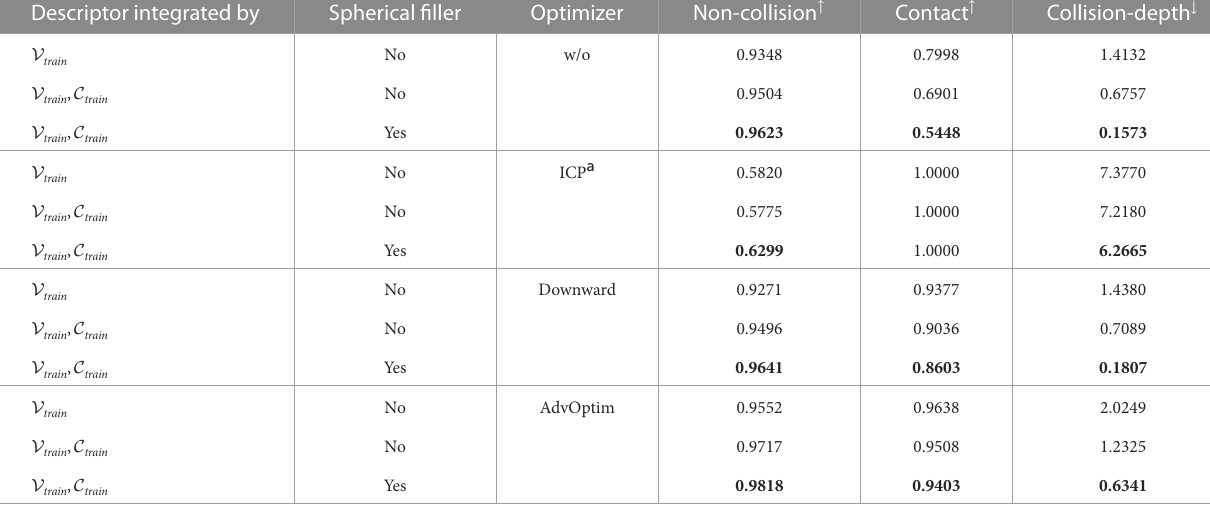
TABLE1 Ablationstudyevaluationscores( ↑ :benefit; ↓ :cost).Thebesttrade-offbetweenscoresperoptimizerareinboldface. Descriptor integrated by